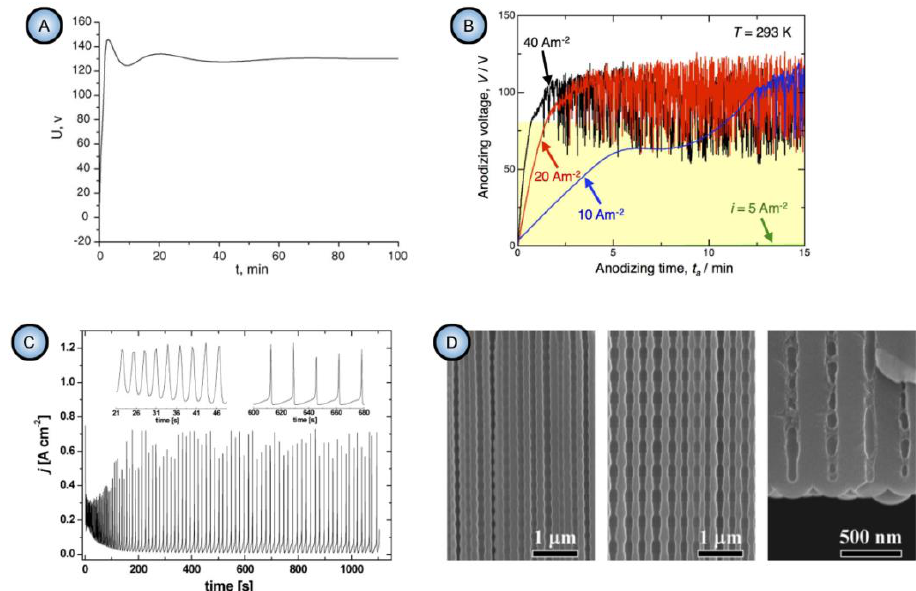
Figure 2. Oscillatory kinetic behavior observed during galvanostatic ( A , B ) and potentiostatic ( C , D ) anodic oxidation of aluminum. ( A ) A voltage–time curve obtained at 1.0 A dm − 2 and 12 ± 1 ◦ C using a mixed electrolyte of phosphoric acid and organic acid and cerium salt (Wang and Wang, [10]); ( B ) Unstable oscillations observed during galvanostatic anodizing of Al at 5–40 A m − 2 using a pyrophosphoric acid solution at 20 ◦ C (Kikuchi et al. [11]); ( C ) Spontaneous current oscillations during potentiostatic anodizing of aluminum at 160 V using a 0.3 M oxalic acid solution at 5 ◦ C (Lee et al. [12]); ( D ) Cross-sectional SEM micrographs demonstrating the nanochannel diameter modulation resulting from the temporal oscillations of the electric current density shown in C [12]. Reproduced with permissions. Copyrights 2006 Elsevier, 2010 Wiley, 2014 Nature.